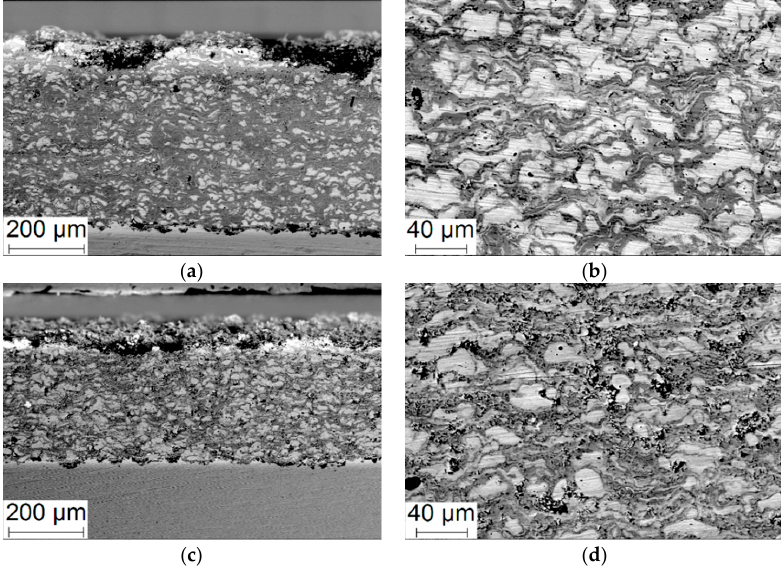
Figure 2. Scanning electron microscope (SEM)-micrographs of the cross section of specimens produced in regime No. 1 ( a , b ) and No. 2 ( c , d ). Table 3. Microstructure characteristics and nanohardness of the coatings detonation sprayed under various